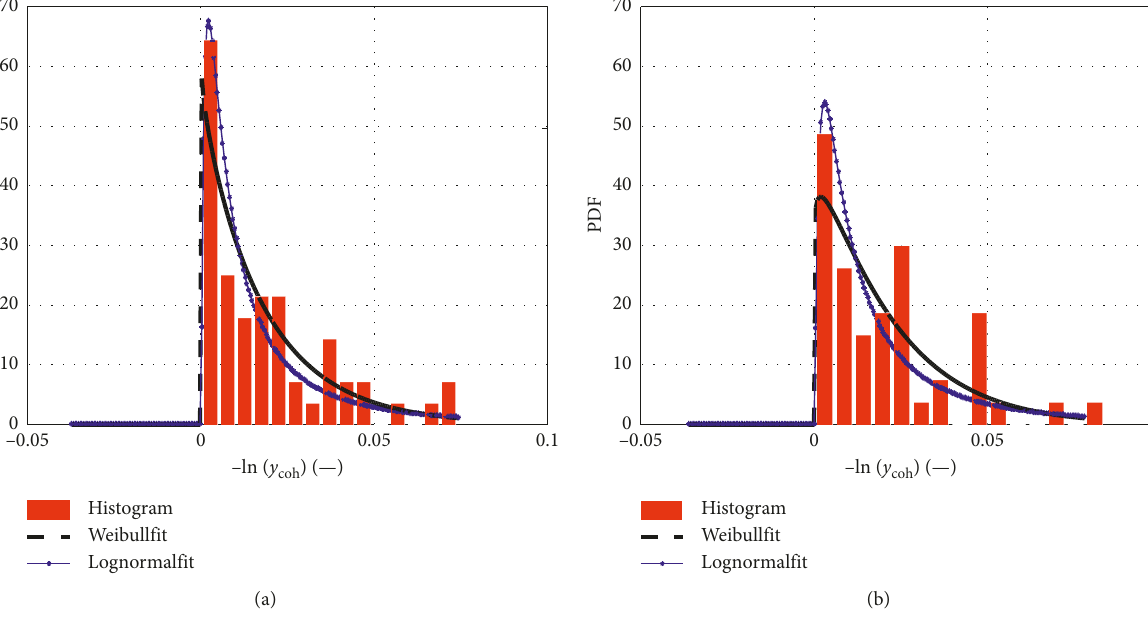
Figure 22: Results for lognormal and Weibull distributions of coherence coefficients at 1.8 Hz with frontal distances of (a) 1m and (b)